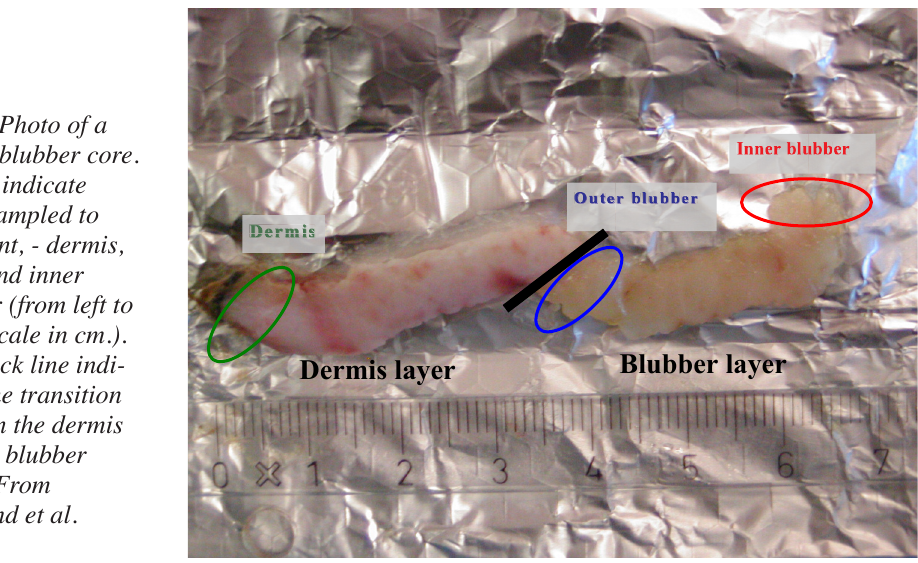
Fig. 7. Photo of a walrus blubber core. Circles indicate areas sampled to represent, - dermis, outer and inner blubber (from left to right; scale in cm.). The black line indi- cates the transition between the dermis and the blubber layer. (From Skoglund et al.